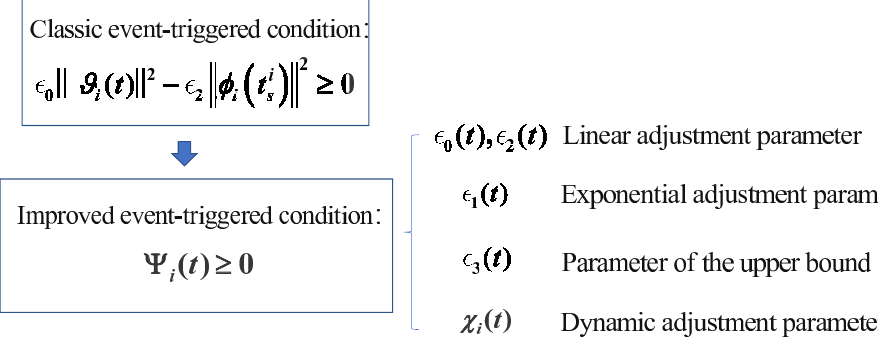
Figure 1. The classical and provide sharper image if available event-triggered scheme is extended to an improved event-triggered scheme. The corresponding advantages are illustrated in Remarks 1–4 and